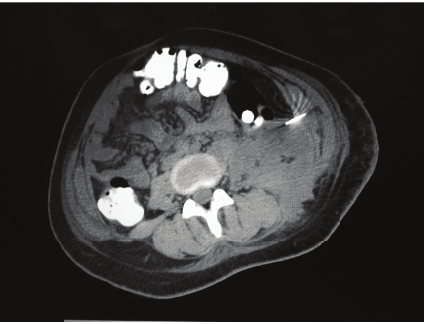
Figure 2: Interventional radiology placement of colonic abscess